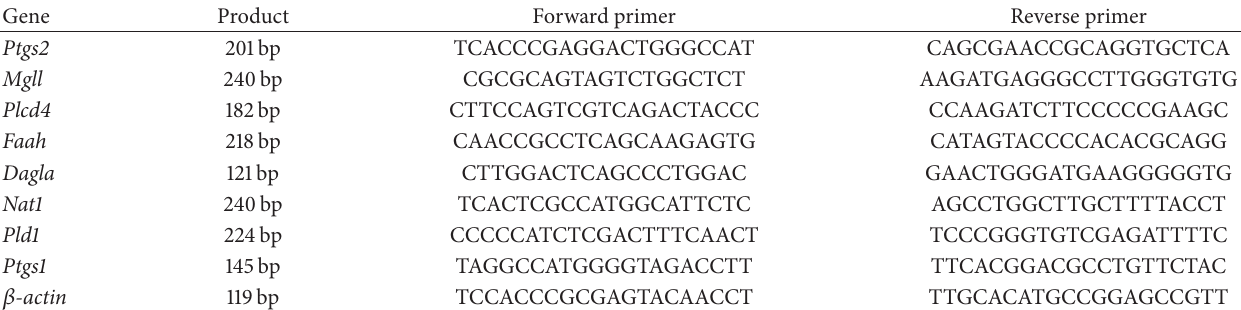
Table 1: Primer sequences (forward and reverse) and product lengths for all genes used in qPCR experiments.